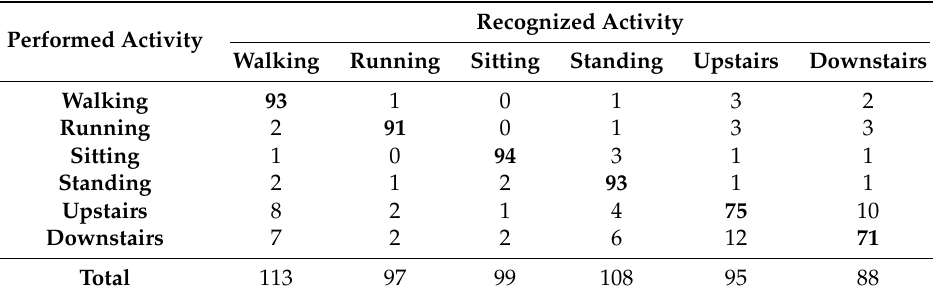
Table 3. Confusion matrix for the internal training